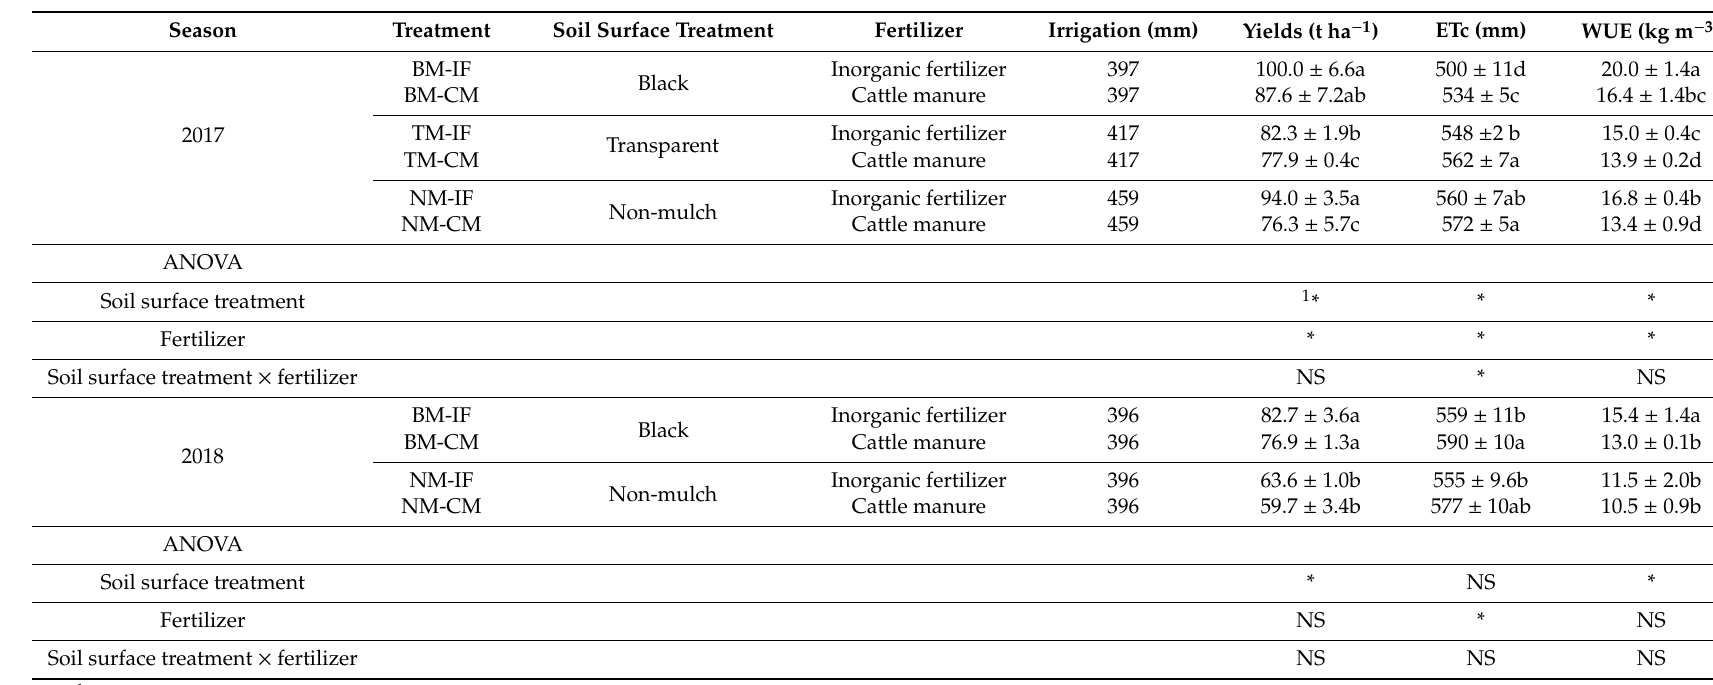
Table 4. Irrigation, tuber yields, evapotranspiration and water use e ffi ciency for potatoes grown with di ff erent mulch treatments and di ff erent fertilizer treatments in 2017 and 2018 at Wuwei, China.